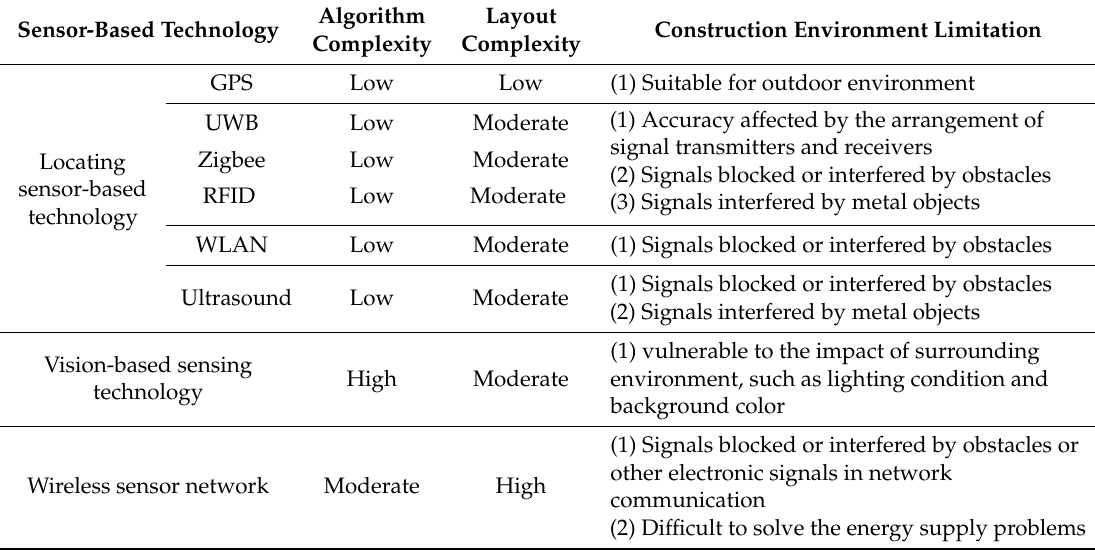
Table 2. Comparison of the three sensor-based technologies’ adaptability.